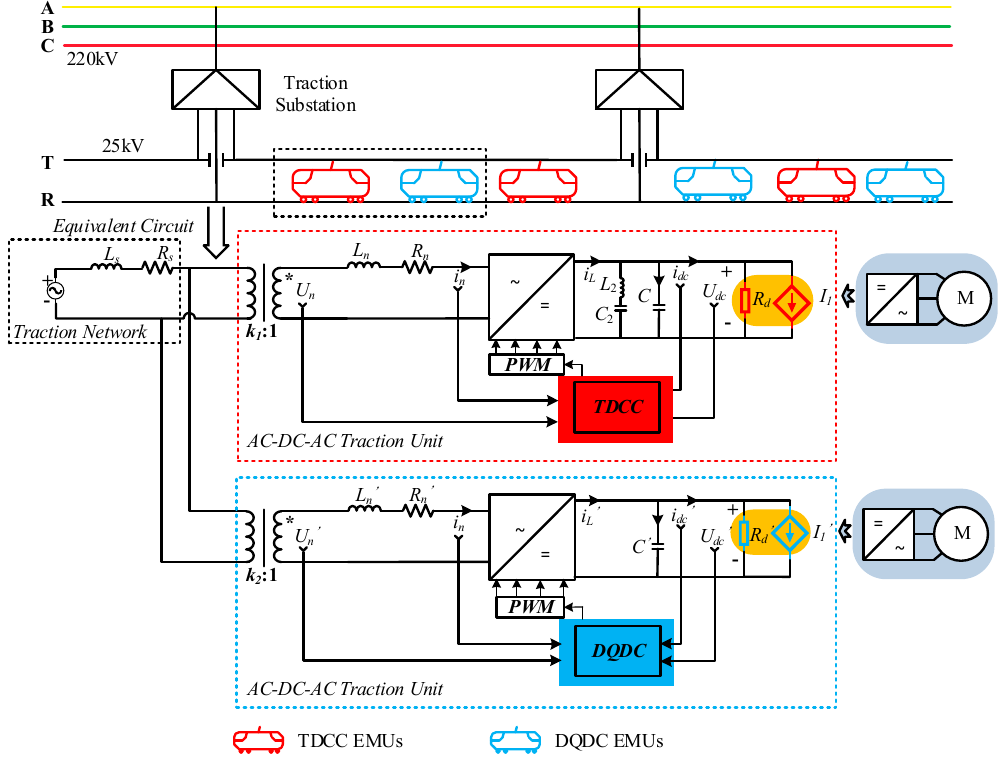
Figure 1. Schematic diagram of mixed operation of passenger and freight locomotives.